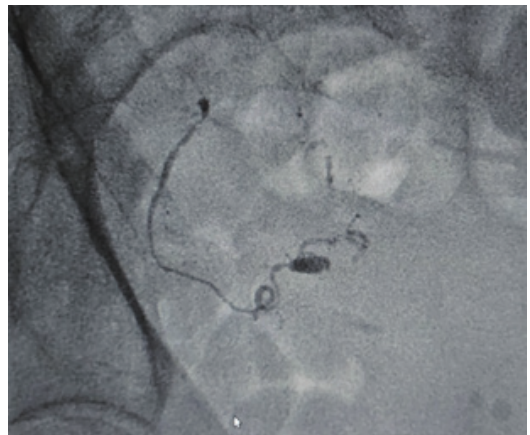
Figure 5 Angiography of the right uterine artery with pseudoaneurysm filling of de embolizing